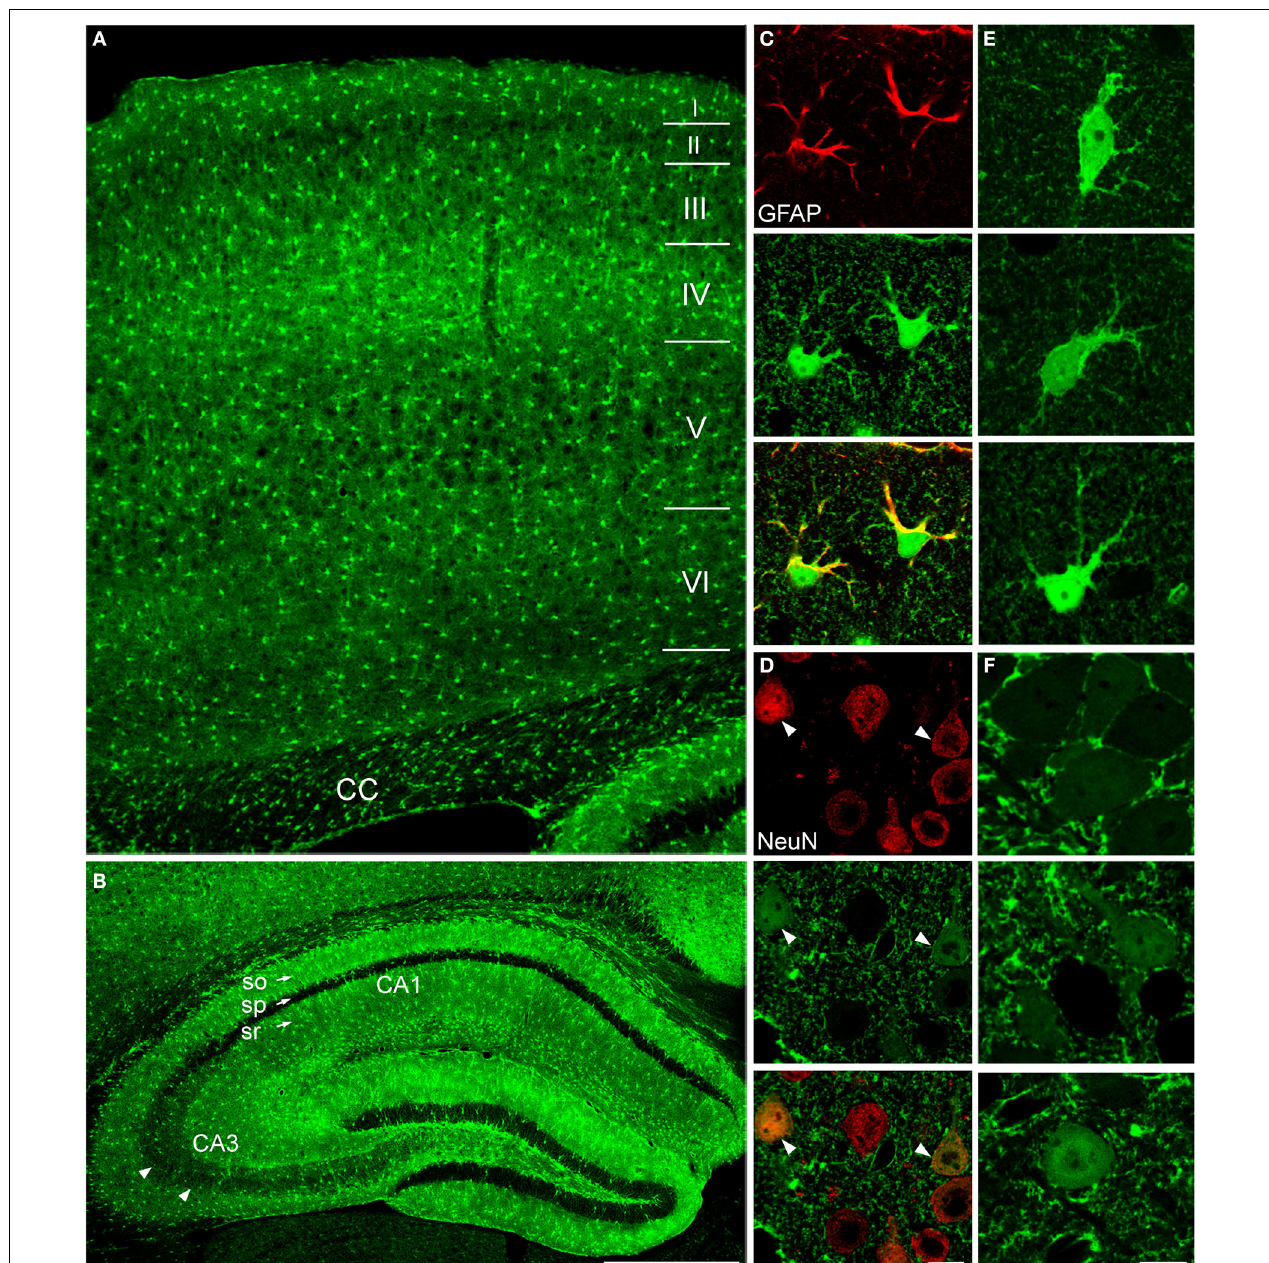
(E) show three astrocyte-like eGFP + cells from CA1 stratum oriens ( upper ), CA3 stratum radiatum ( middle ) of hippocampus and layer VI of SI ( bottom ); images in (F) show three neuron-like eGFP + cells of CA3 stratum pyramidale of hippocampus ( upper ) and layer VI of SI ( middle and bottom ). Abbreviations: CC , corpus callosum ; so , stratum oriens ; sp , stratum pyramidale ; sr , stratum radiatum . Roman numerals indicate neocortical layers. Scale bar (A,B) : 150 µm; scale bar (C–F) : 10